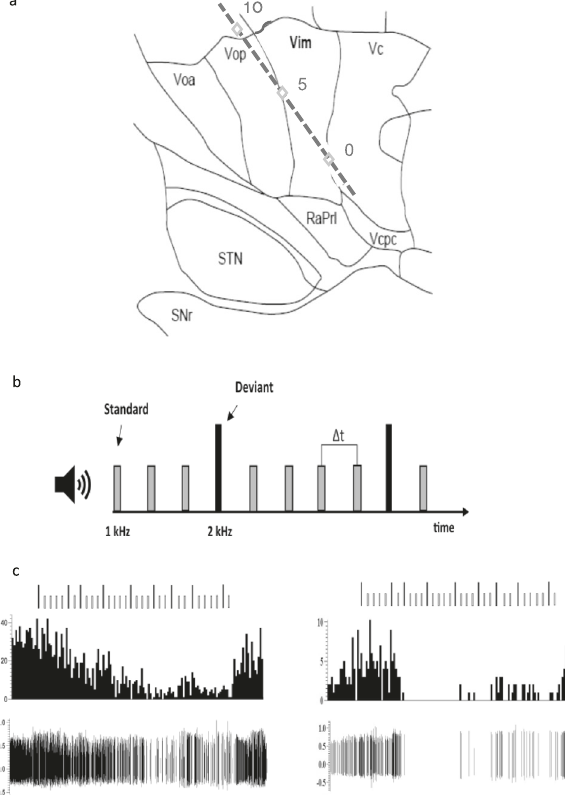
Fig. 1 A typical microelectrode track and the behavioral task. a A representation of the microelectrode track through the motor thalamus targeting the Vim/Vc (0) border passing through Vop. A second series of trajectories (not shown) were more anterior and targeted the Vop/Vim border and passed through Voa. Track is presented on a 14.5 mm sagittal map from Schalterbrand and Wahren 47 . A few recordings were made from thalamic reticular nucleus in tracks targeting the STN located more anterior still. RaPrl prelemniscal radiations, Vcpc ventral caudal parvocellular. b A schematic representation of the auditory oddball task. Patients were presented two different tones standard (1 KHz, 80% of the tones) and deviant (2 KHz, 20% of the tones) with the same interstimulus time. Patients were asked to count and report the number of deviant tones. In fi ve trials, patients were also asked to move